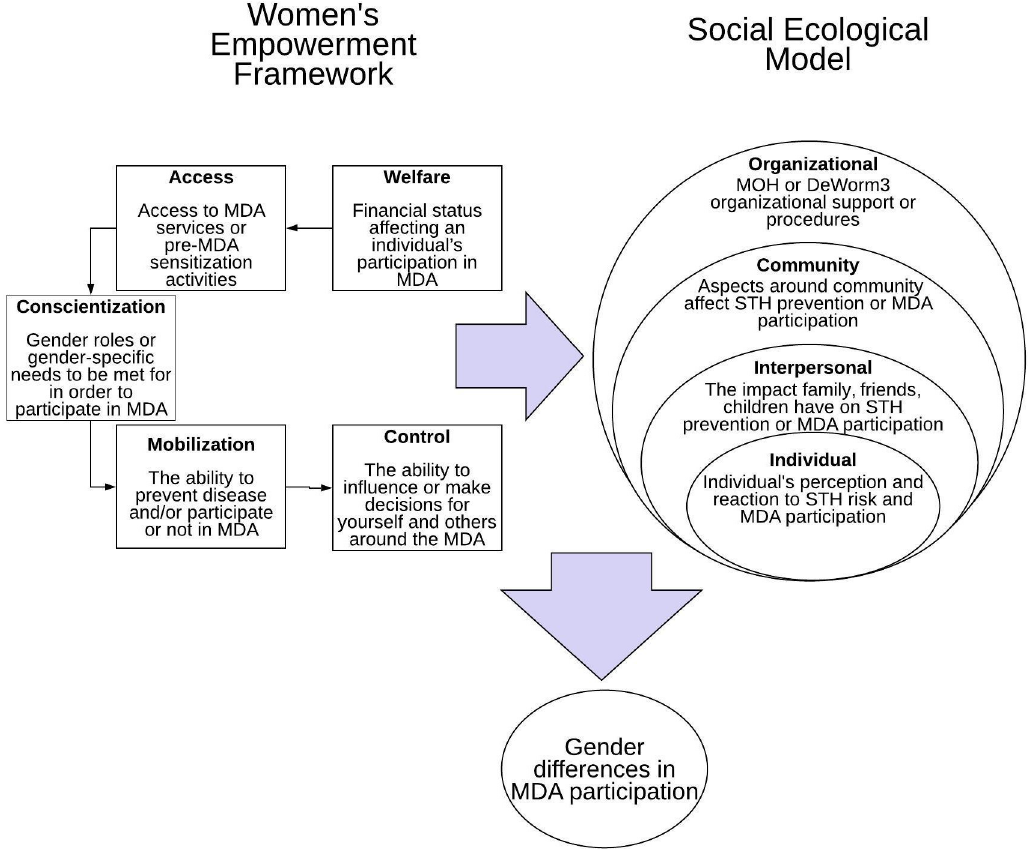
Fig 1. Conceptual framework combining Women’s Empowerment Framework (WEF) with the Social Ecological Model (SEM).